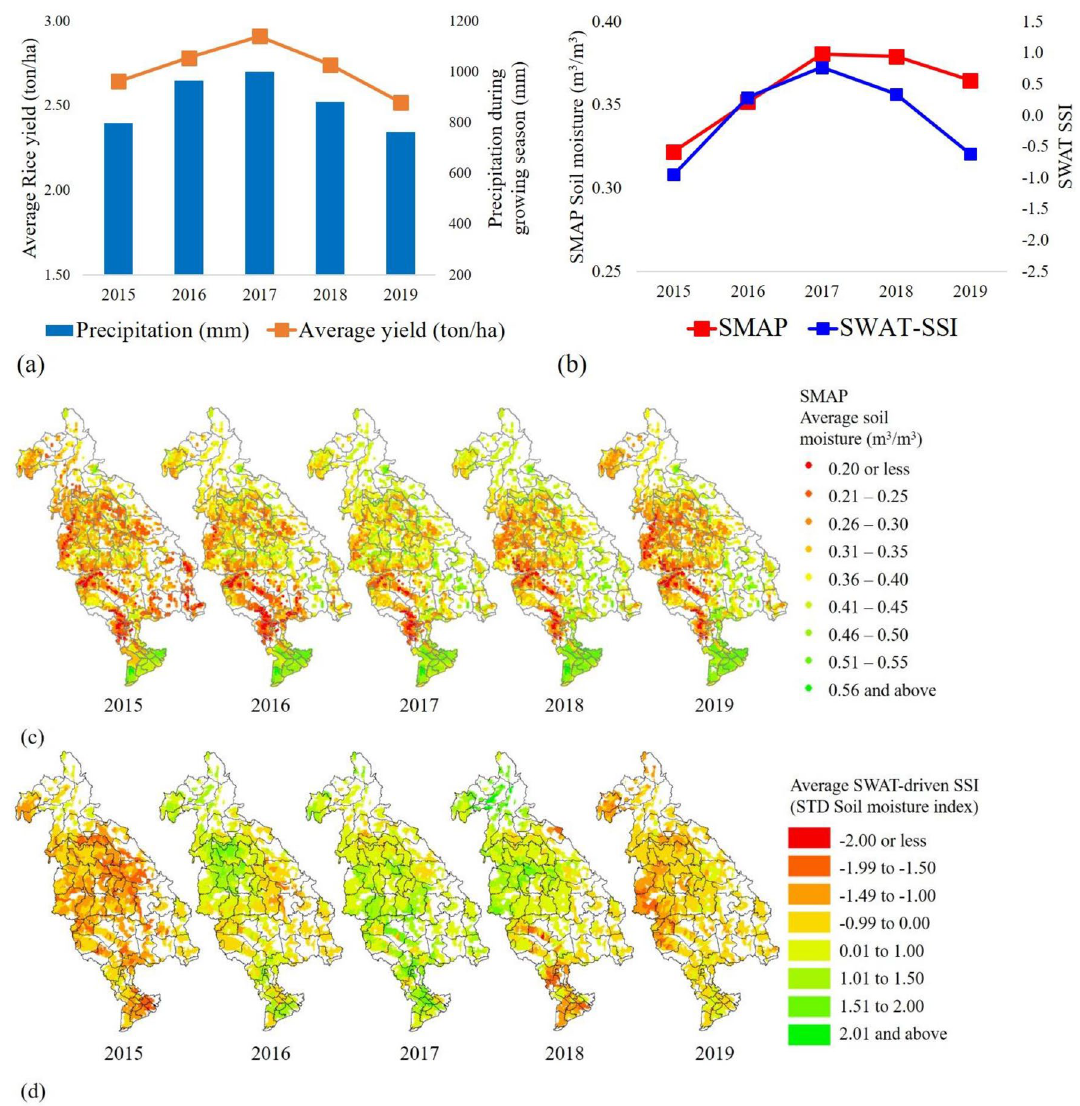
Figure 4. Comparisons of the SMAP soil moisture, model-driven drought index, and simulated rice yield for the last 5 years of the historical period (2015–2019). ( a ) Bar and line chart for precipitation and average rice yield. Blue bar represents the total precipitation amount during the crop growing season, and orange bar indicates the average rice yield for entire LMB. ( b ) Red line represents the average SMAP soil moisture during crop growing season, and blue line indicates the average model-driven SSI (Standardized Soil moisture Index: SSI) ( c ) Spatial maps of the average SMAP soil moisture ( d ) Spatial maps of the average model-driven SSI. Spatial maps were created using ArcMAP10.5 software by Esri (www. esri.